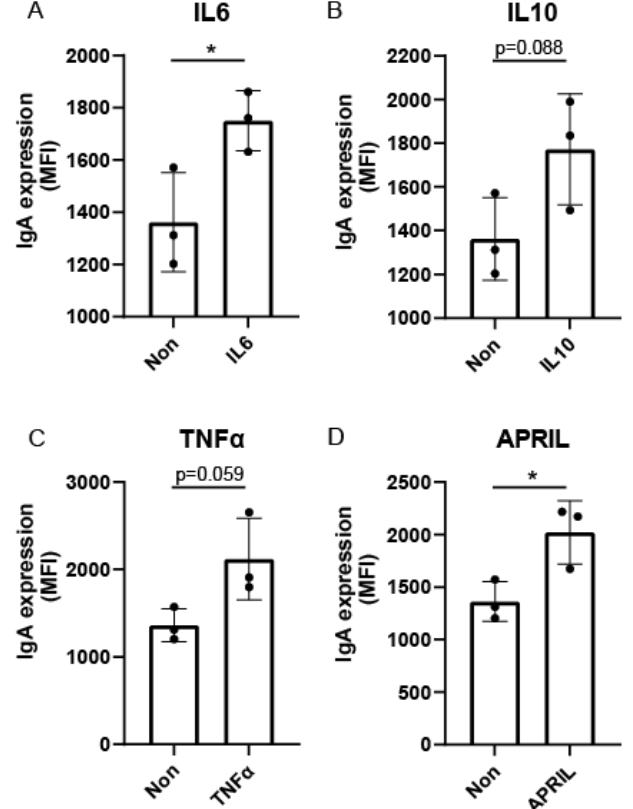
Figure 4. Exogenous recombinant cytokines induce IgA class switching in naïve B lymphocytes. Human naïve B cells were isolated from peripheral blood and cultured in the presence of T-cell- dependent stimuli, including interleukin-4, anti-CD40, and anti-IgM antibodies. In addition, B cells were supplemented with exogenous ( A ) interleukin-6, ( B ) interleukin-10, ( C ) tumor necrosis factor- α , or ( D ) APRIL. On day 7, IgA membrane expression was measured on B cells using flow cytometry ( n = 3). Data are presented as the mean ± SD. Student’s t test, * p < 0.05.